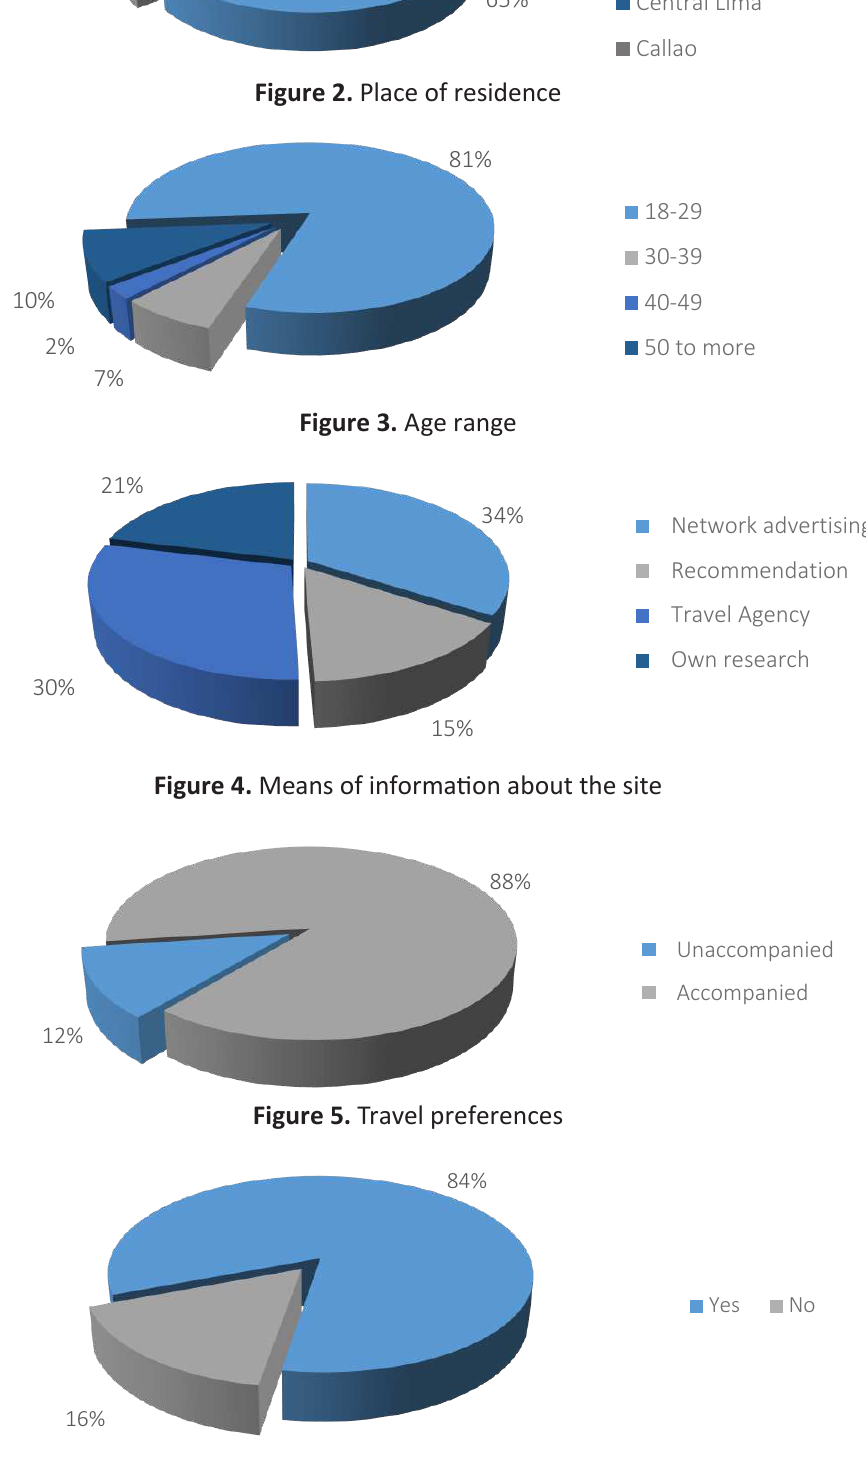
Figure 2. Place of residence